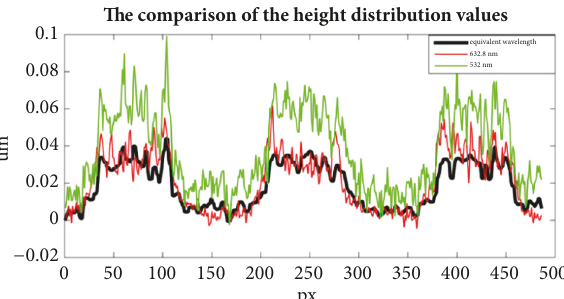
Figure 7: The comparison of the height distribution values along the middle symmetrical line of sample in pane Figures 5(a), 5(b), and 6(a).